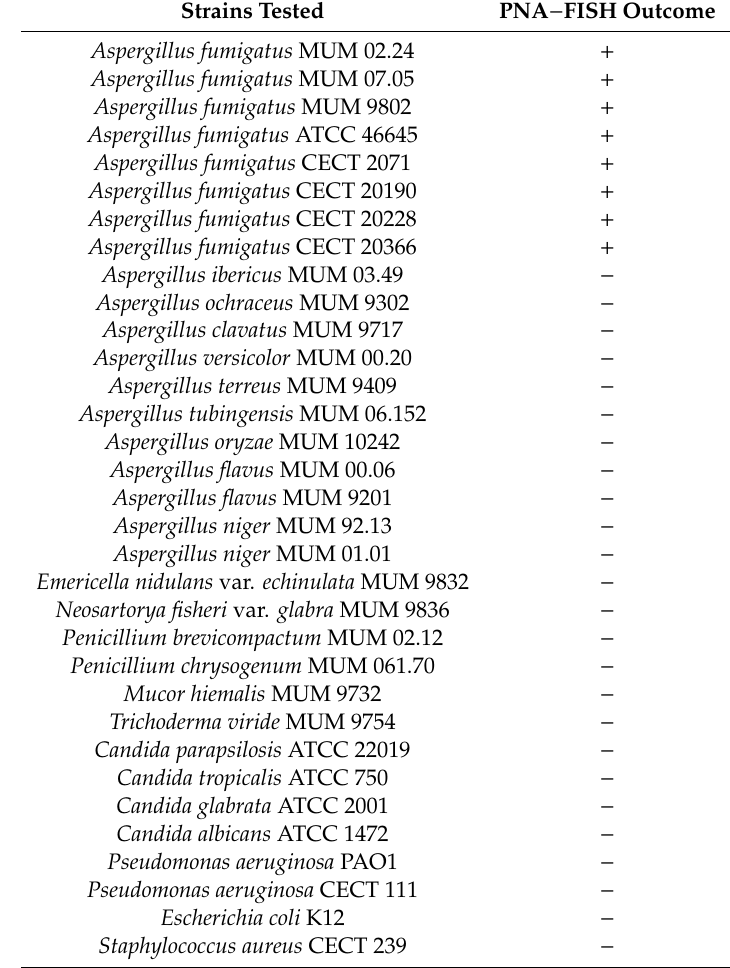
Table 1. List of strains used in this study, together with the results obtained with the peptide nucleic acid-fluorescence in situ hybridization (PNA-FISH) probe specificity / sensitivity test. CECT, Colecci ó nEspañoladeCultivosTipo; MUM,MicotecadaUniversidadedoMinho;